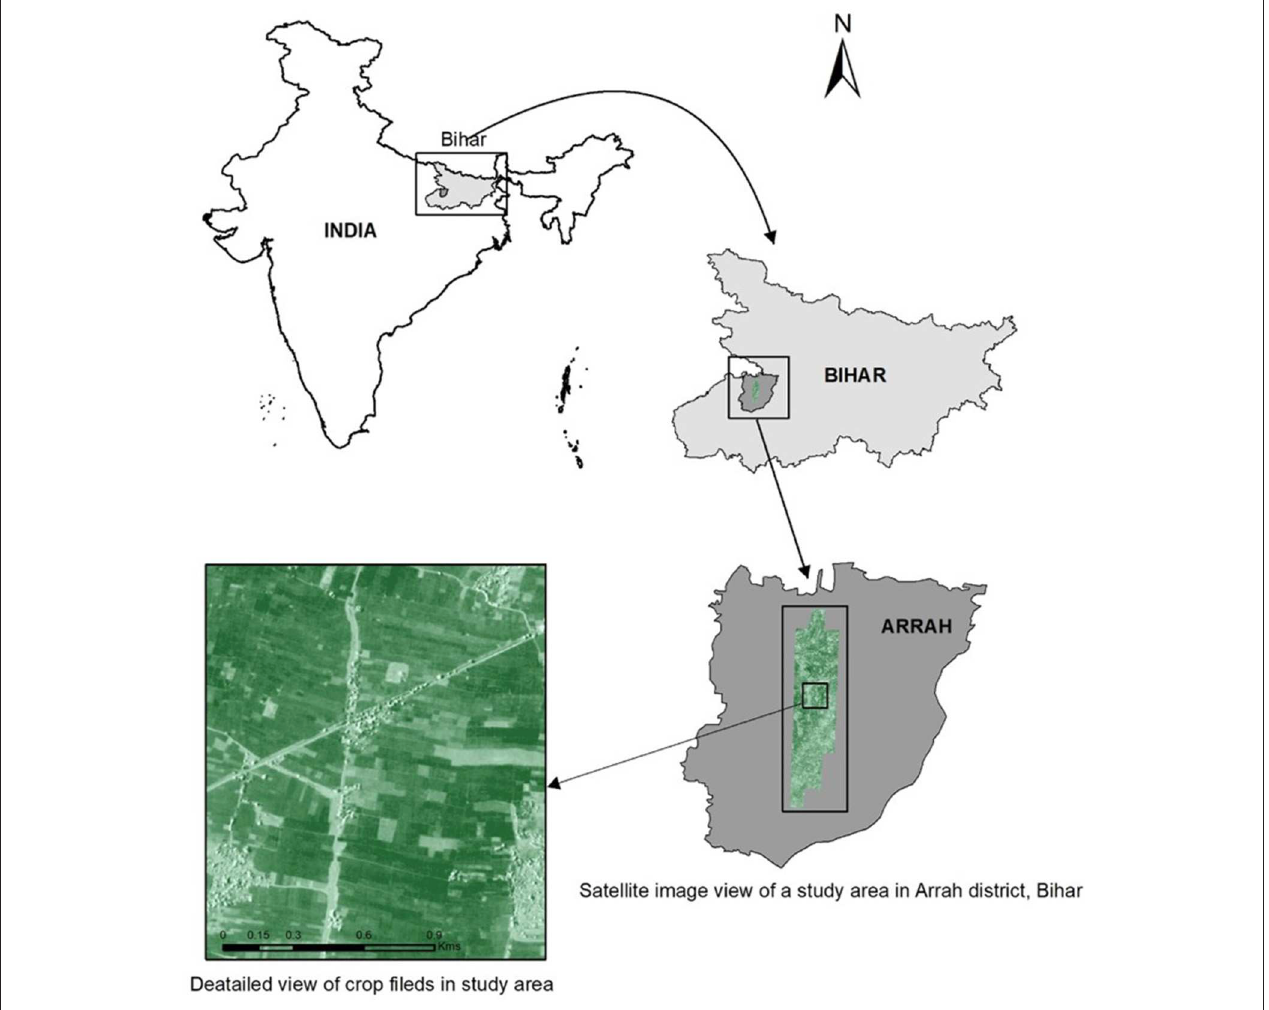
FIGURE 1 | Study area, a region in Arrah district in Bihar,